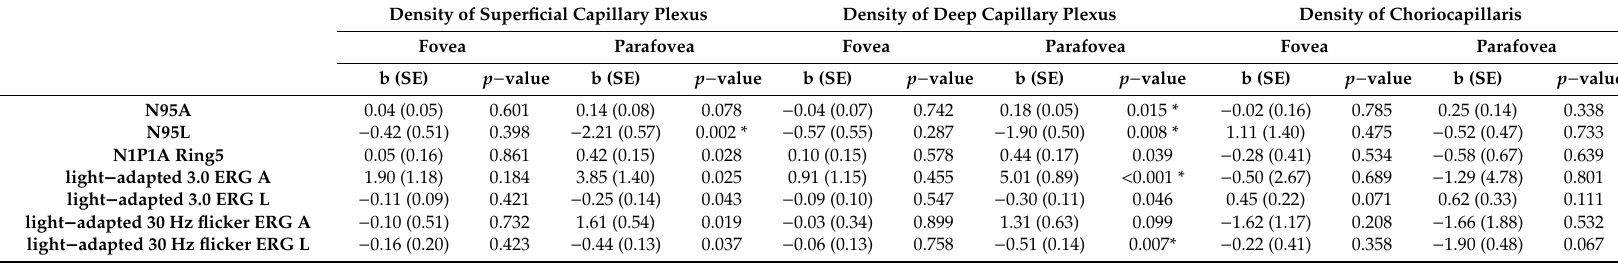
Table 5. Mixed-e ff ects models using the eye as the unit of analysis performed to assess the e ff ect of morphological parameters on functional parameters.